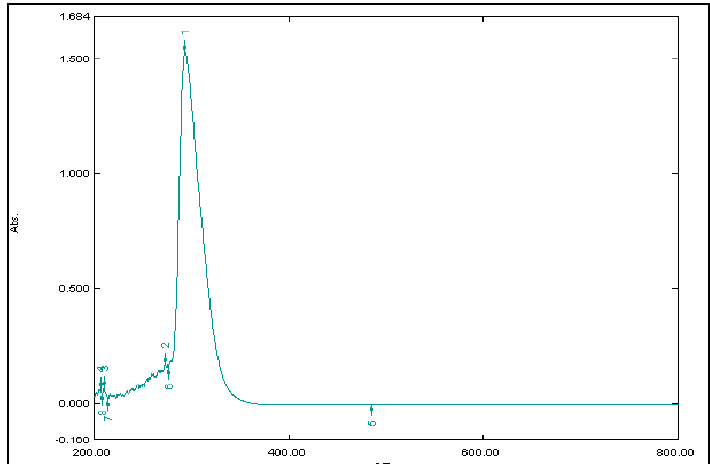
Figure 9. The UV-visible spectrum of CPN.